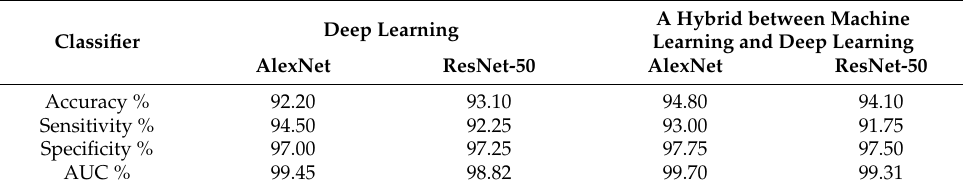
Table 10. Alzheimer’s disease diagnosis results using deep learning and hybrid models between deep learning and machine learning.